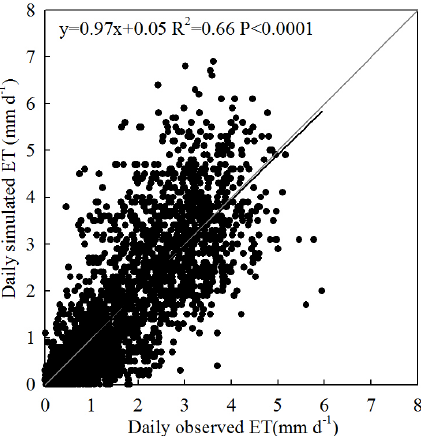
Fig. 4. Comparison between simulated and observed ET (mmd − 1 ) at all five tower